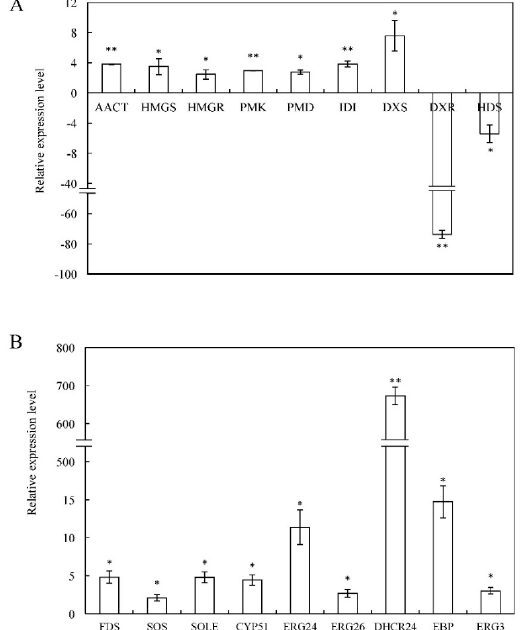
Figure 3. RT-qPCR analysis of selected genes involved in 20E biosynthesis. ( A ) Unigenes involved in terpenoid backbone biosynthesis. ( B ) Unigenes involved in steroid biosynthesis. Leaves and roots of four-month old C. arachnoidea were collected and their total RNAs were used for RT-qPCR analysis. Relative expression level of unigenes in roots was calculated by the 2 − ∆∆ C t method with actin as an internal control and was compared to those in leaves, which were all set to be 1. The negative value represents higher expression levels of unigenes in leaves than in roots. The error bar indicated standard deviations of three biological replicates. Asterisks represented significant differences: * p < 0.05 and ** p < 0.01. The full names of the abbreviations (unigenes) are provided in Table